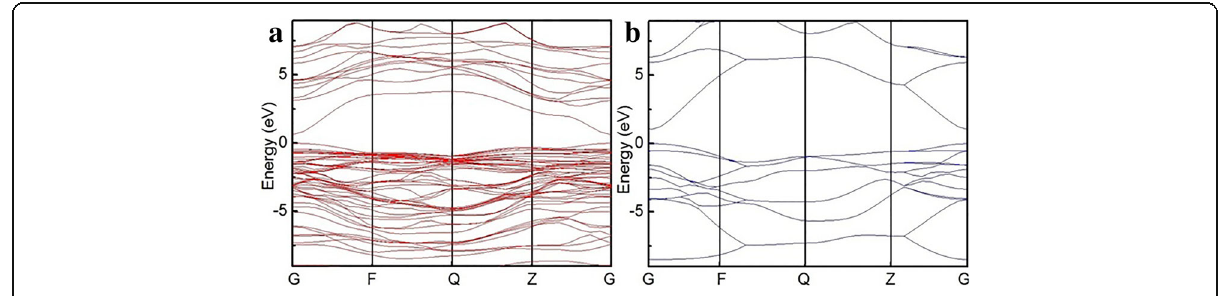
Fig. 7 Band structure of a Eu-SnO 2 and b SnO